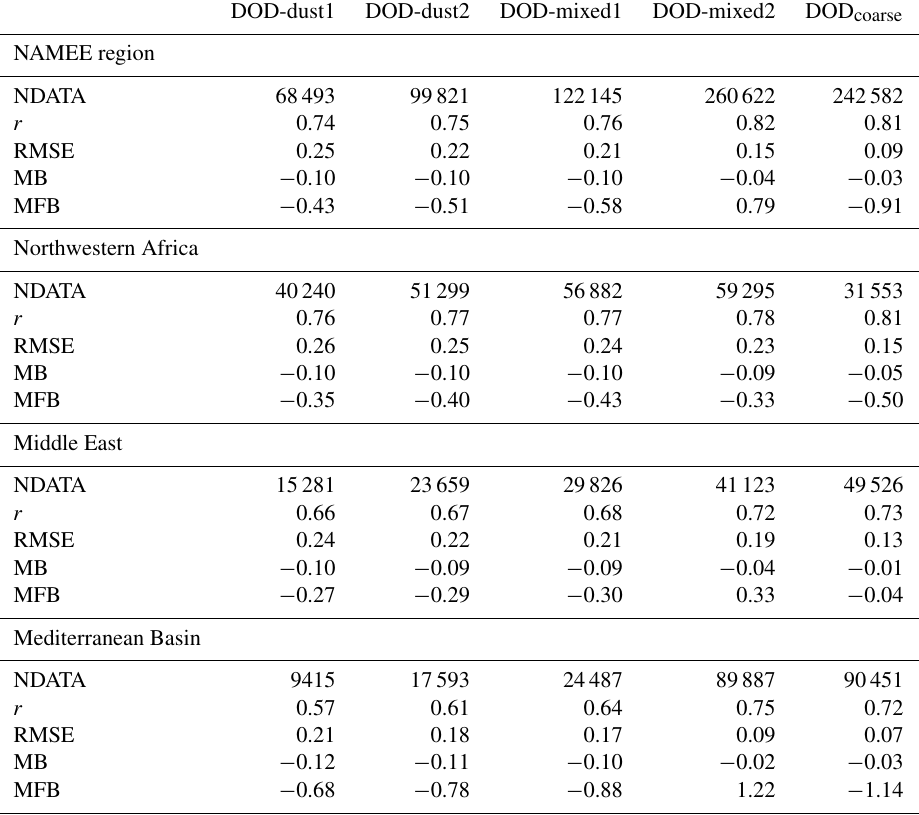
Table 7. Verification statistics ( r , RMSE, MB and MFB) and number of samples (NDATA) for the reanalysis versus AERONET AODs for the entire period (2007–2016) and NAMEE region and for northwestern Africa, the Middle East and Mediterranean regions. AERONET version 3, cloud-screened, 3-hourly, dust-filtered AOD and AOD coarse comprise the reference. The definition of each of the DOD filters is in Table